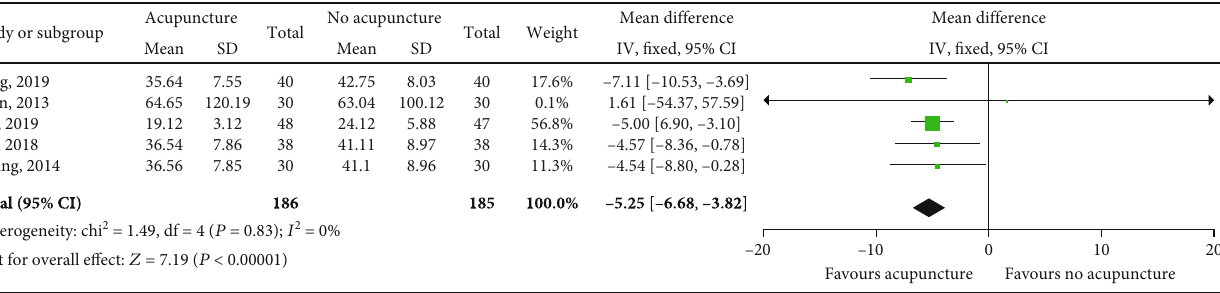
Figure 7: Impact of acupuncture on TBIL. Both I 2 and P represent the criteria for the heterogeneity test. ♦ : pooled mean di ff erence; — ■ — : mean di ff erence and 95%